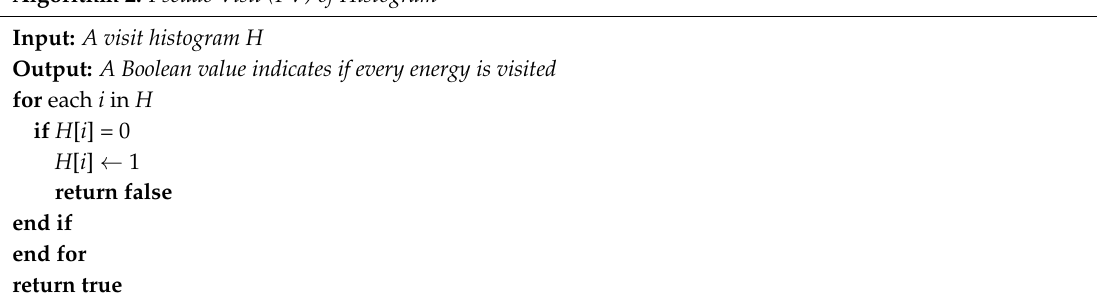
Table 1. Properties of test problems with random structure.